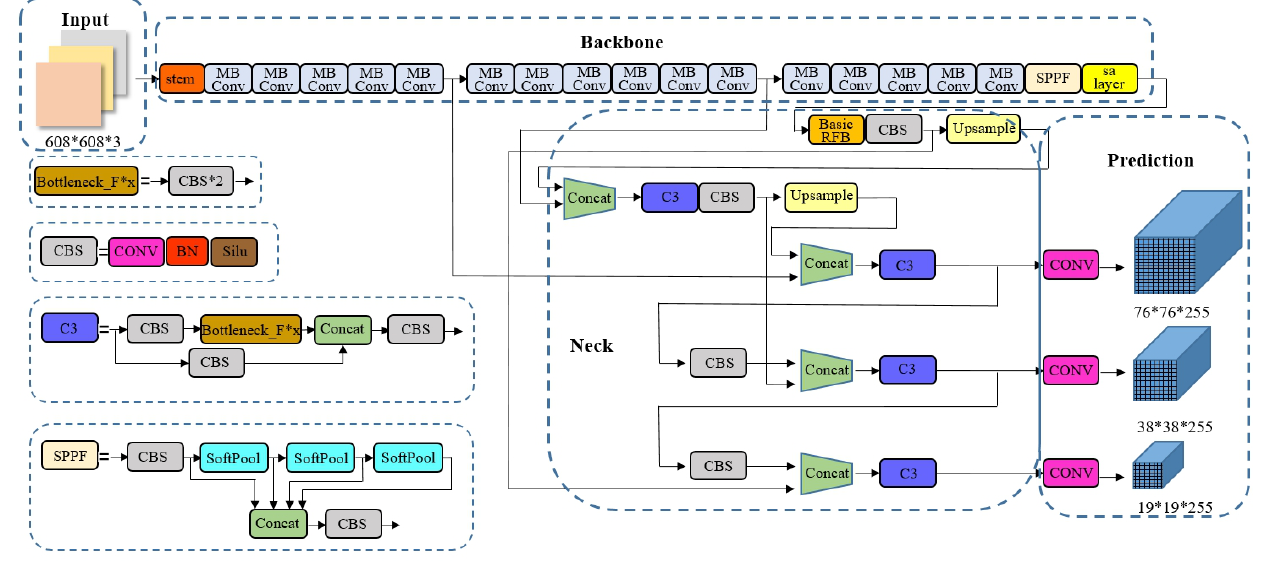
Figure 2. Efficient YOLOV5 model structure.